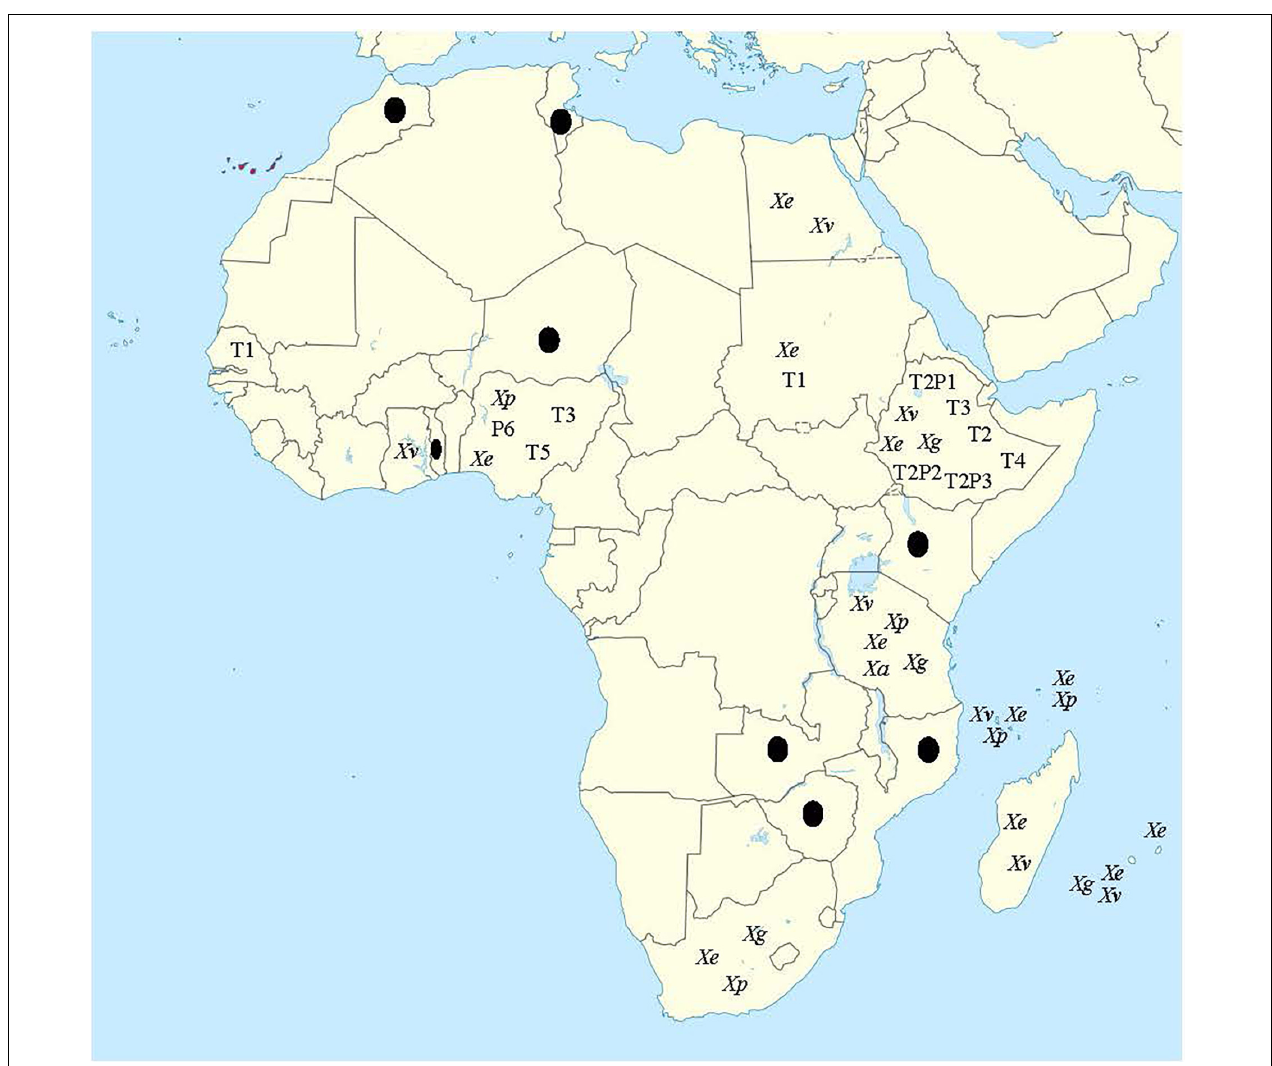
FIGURE 2 | Map of Africa showing countries where bacterial spot disease has been reported on tomato and/or pepper. Xe , Xp , Xg , and Xv represent X. euvesicatoria ( X. euvesicatoria pv. euvesicatoria ), X. perforans ( X. euvesicatoria pv. perforans ), X. hortorum pv. gardneri , and X. vesicatoria , respectively. Xa represents X. arboricola reported only in Tanzania. Races include T1, T2, T3, T5, T2P1, T2P2, and T2P3. Countries with black dots are those for which bacterial spot have been reported, but neither species nor race was identified. Map for this figure was obtained from